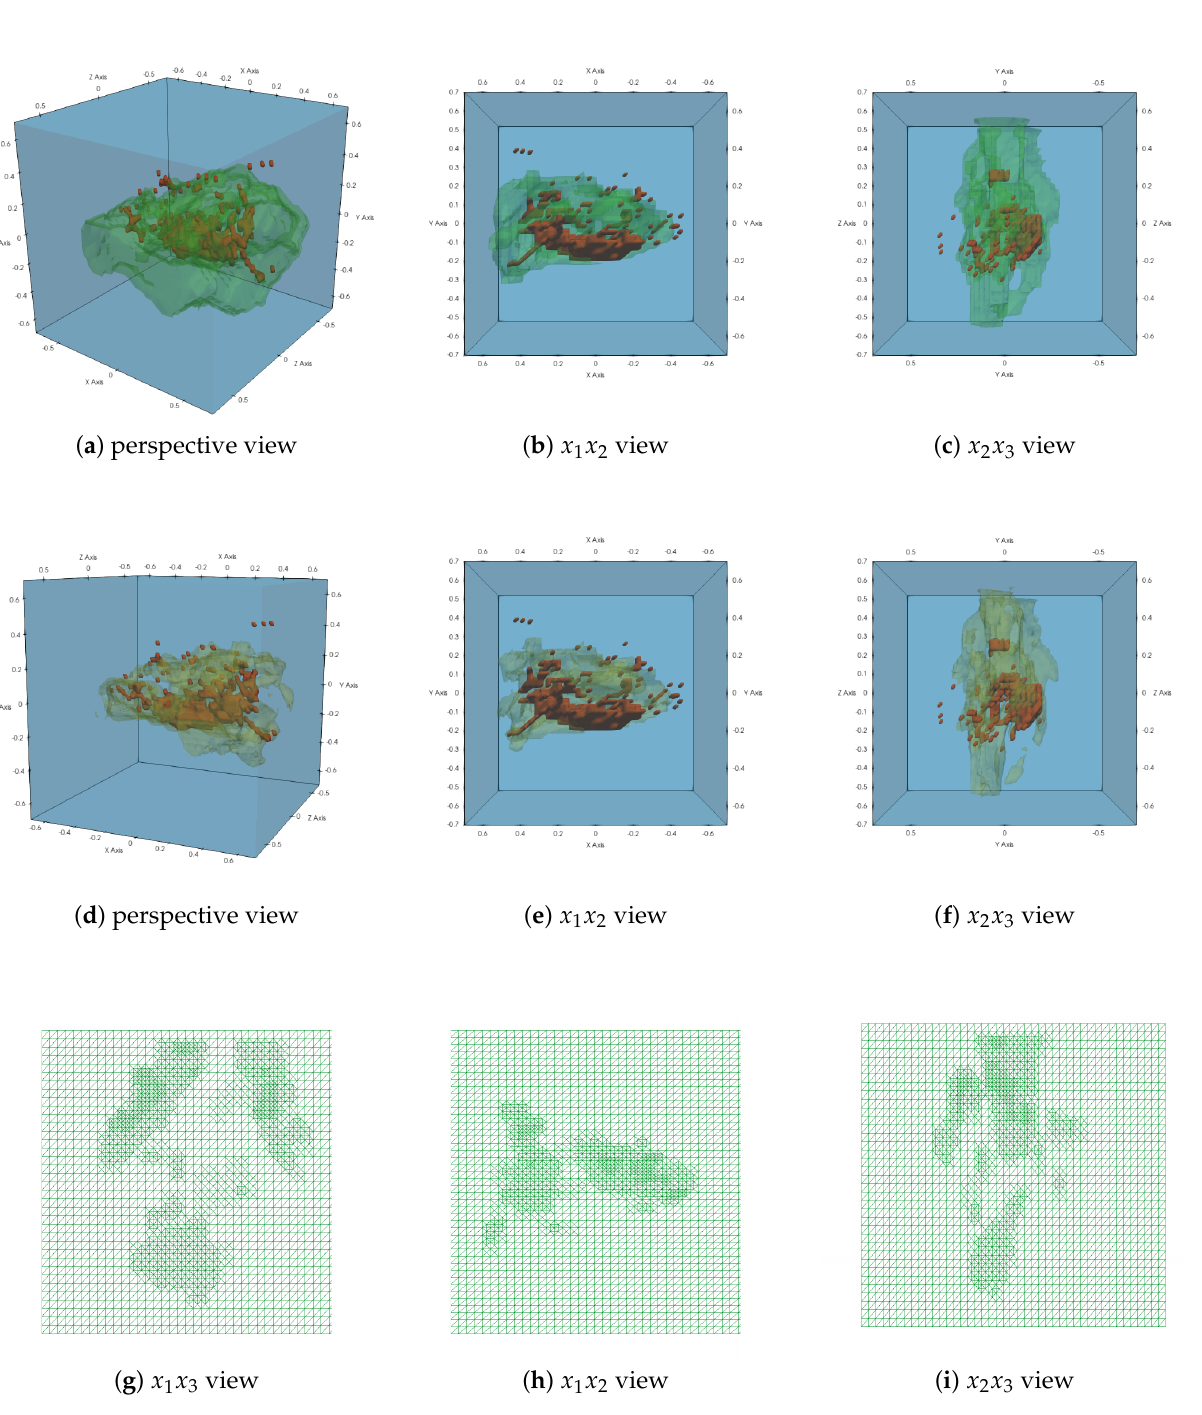
5.0 (outlined in transparent green color) of ε r ob- Figure 11. Test 1. ( a – c ): Reconstructions ε h 0 ≈ tained on the coarse mesh. ( d – f ): Reconstructions ε h 2 5.0 obtained on refined mesh K h 2 . ( g – i ): ≈ refined mesh K h 2 . The noise level in the data is δ = 10%. See Table 2 for obtained contrasts ε hk , k = 0,1,2. For comparison, we also present the exact isosurface with values correspond- max Ω FEM ing to reconstructed ones and outlined in the red